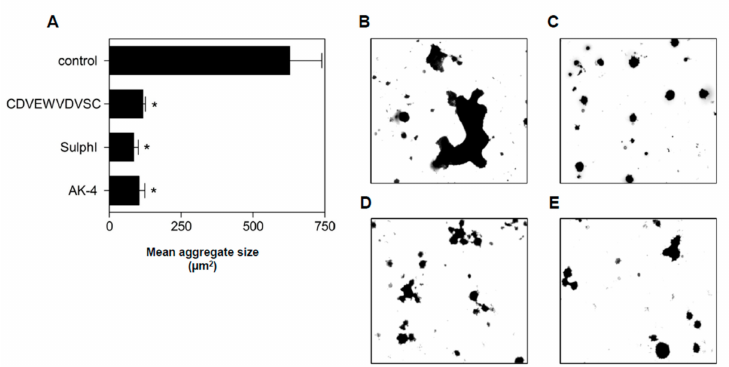
Figure 5. Inhibition of aggregate formation by P-selectin antagonists. ( A ) Mean aggregate size after ADP-induced aggregation of human PRP (platelet-rich plasma) in the absence (control) and presence of CDVEWVDVSC (100 µ M), anti-sulfatide antibody SulphI (10 µ g / mL), or P-selectin blocking antibody AK-4 (10 µ g / mL). Following aggregation, aggregates were applied to microscope slides, stained with May-Grünwald-Giemsa, and analyzed by light microscopy. Mean aggregate size was evaluated by the ‘watershed’ function of the Optimas 6.2 software. Data are means ± S.E.M, n = 3. ( B–E ) Microscopic high power views show aggregate formation in the presence of ( B ) bu ff er, ( C ) CDVEWVDVSC, ( D ) P-selectin blocking antibody AK-4, and ( E ) anti-sulfatide antibody